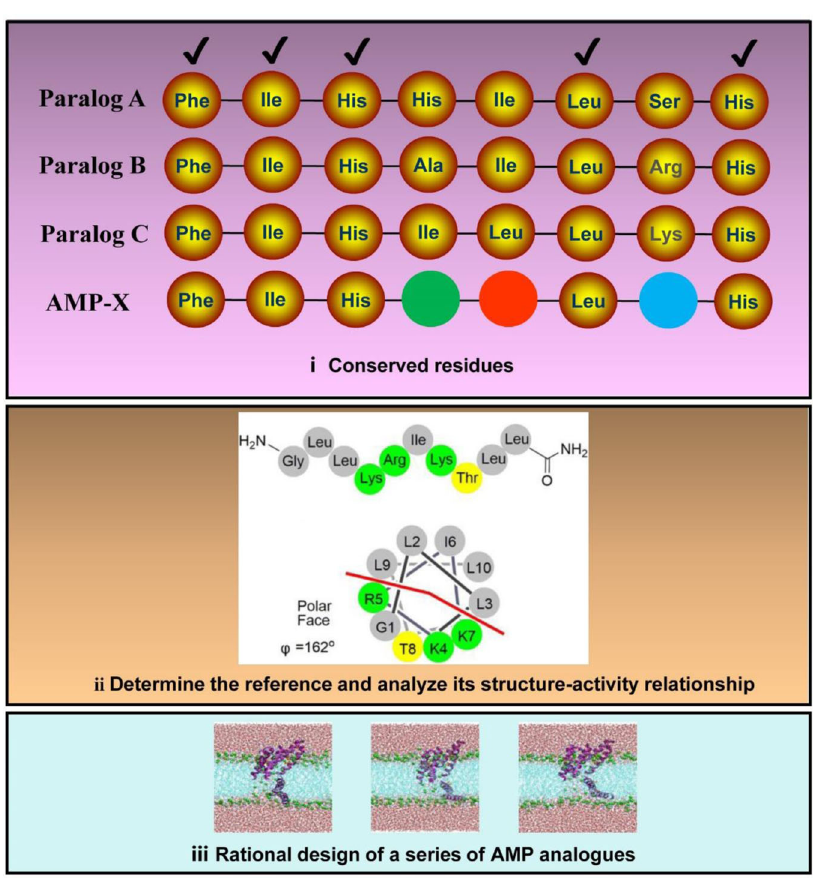
Fig. 1 Schematic diagram of AMPs designed based on bioinformatics. First, amino acids involved in conserved structures in multiple homologous AMPs (Paralog A, Paralog B, and Paralog C) are quickly identi fi ed and retained in AMP-X. Secondly, site-directed mutations of other amino acids in AMP-X (marked with green, red, and blue spheres, respectively) are performed based on the structure-activity relationship knowledge of template AMPs. Finally, MD simulations are used to describe the interaction between AMP-X and cell